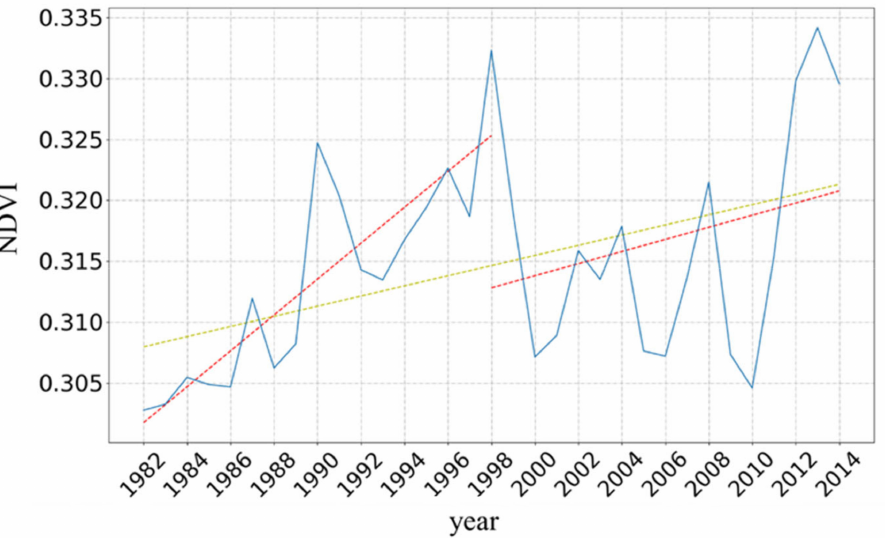
Figure 1. Regional mean NDVI time series for the 1982–2014 growing season in northern East Asia. The growing season is defined here as April–October for 20 ◦ N–70 ◦ N. The red line in the figure represents the trend of growing season NDVI from 1982–1998 and 1998–2014, the blue line represents the regional average of NDVI from 1982–2014, and the yellow line represents the overall trend from